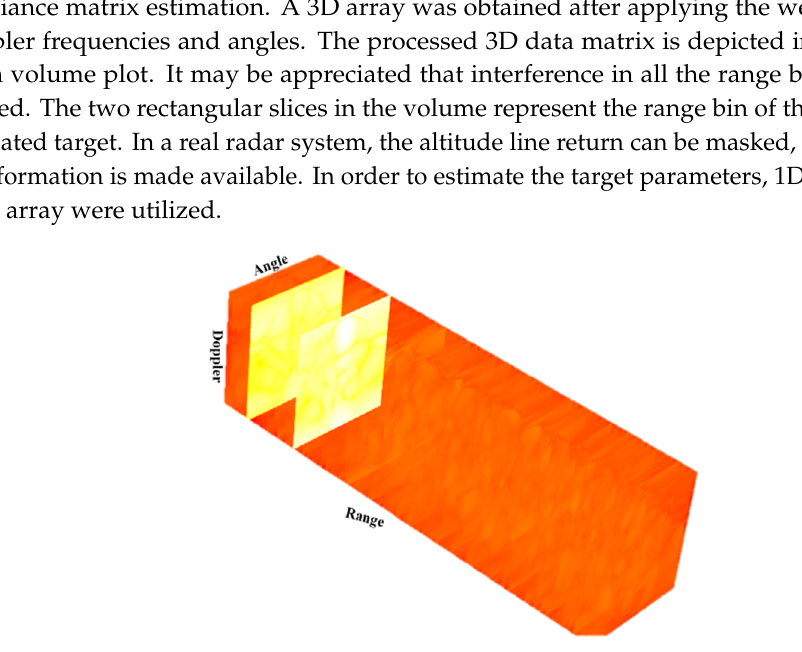
Figure 11. Weight vector response after adaptive Doppler compensation.